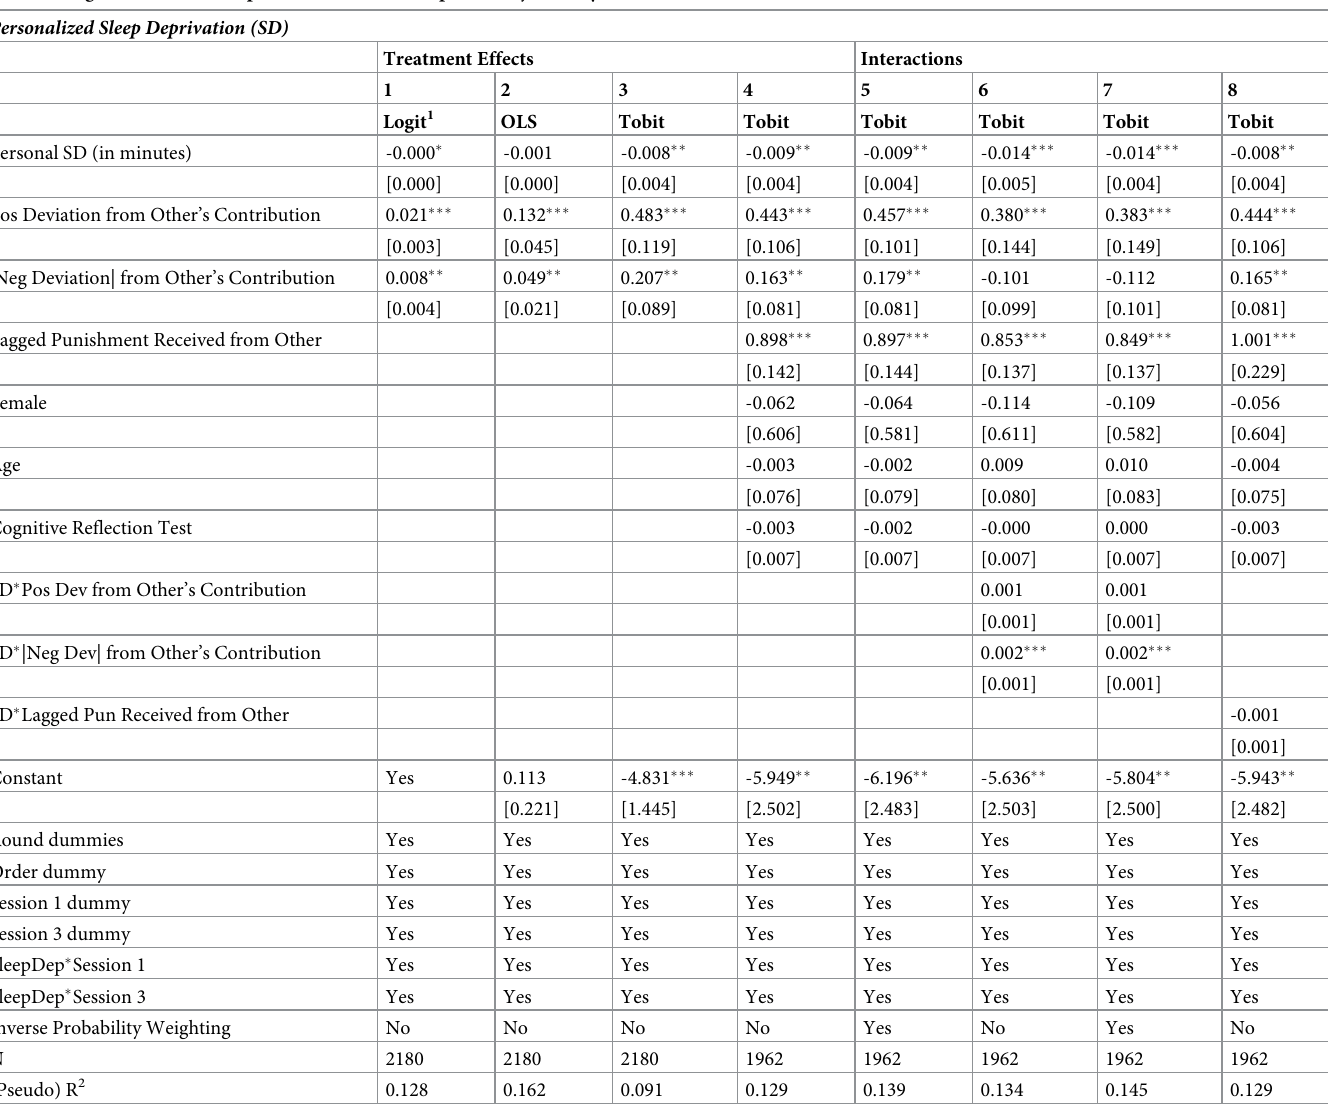
Table 7. Regression results for punishment sent—compliant subjects